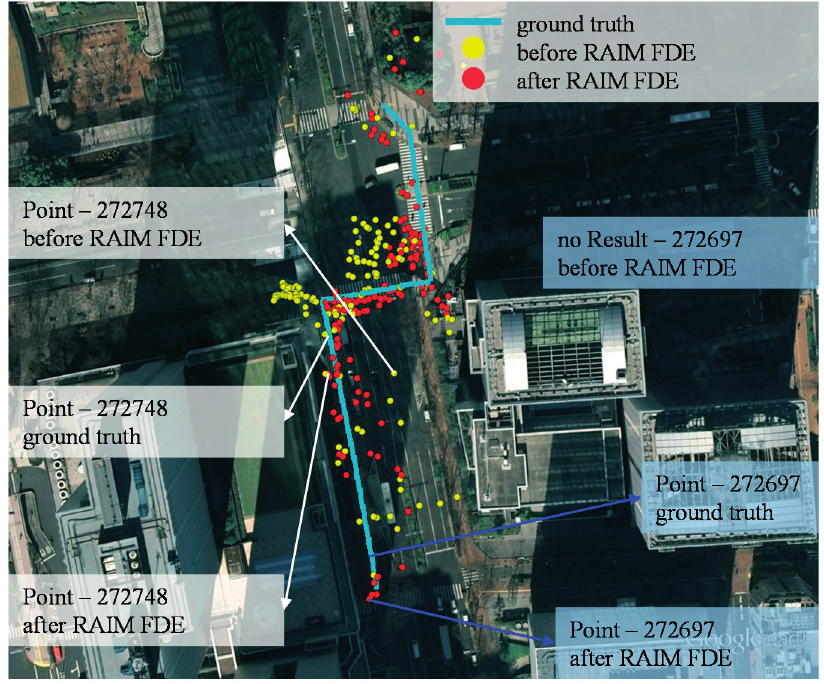
Figure 12. Results of the proposed 3D map positioning method before and after using the RAIM satellite selection method in the deep urban